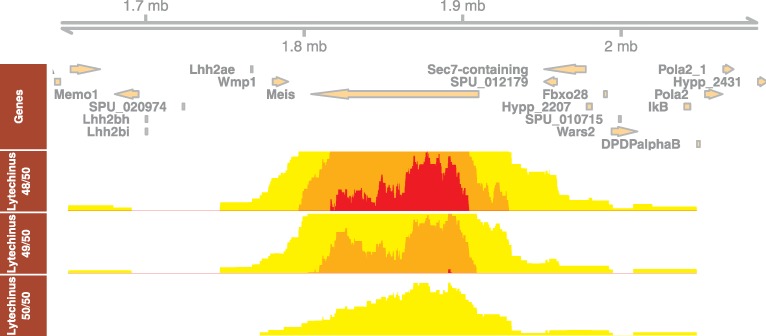
Horizon plot of CNE density at Meis loci on sea urchin Strongylocentrotus purpuratus.The density plots of CNEs detected at similarity threshold 96% (48/50), 98% (49/50) and 100% (50/50) over 50 bp sliding window, in Lytechinus variegatus comparison, are shown in three horizon plot tracks. The boundaries of CNE clusters from various thresholds are mutually consistent.